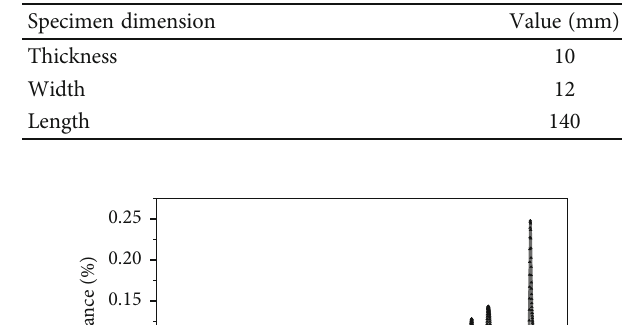
Table 3: Rectangular specimen dimension for compression testing.